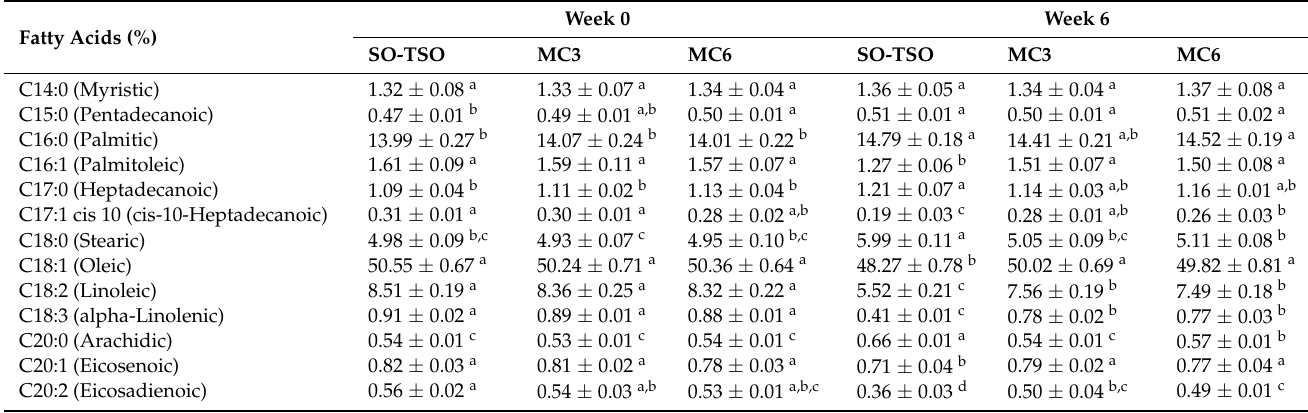
Figure 4. Peroxide value ( a ) and TBARS values ( b ) of SO-TSO, oil extracted from MC3, and oil extracted from MC6 stored for 0 and 6 weeks. Bars represent the standard deviation ( n = 3). Different lowercase letters on the bars denote significant difference ( p < 0.05) (for Captions, see Figure 1). Table 3. Fatty acid profile of SO-TSO, oil extracted from MC3, and oil extracted from MC6 on the 0th and 6th week of